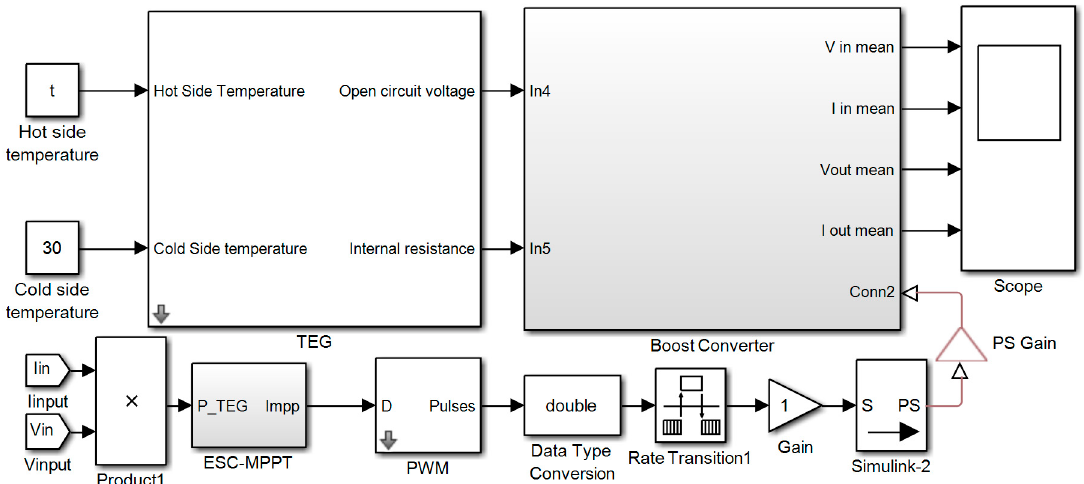
Figure 8. The Simulink model of TEG/dc-dc boost converter system.